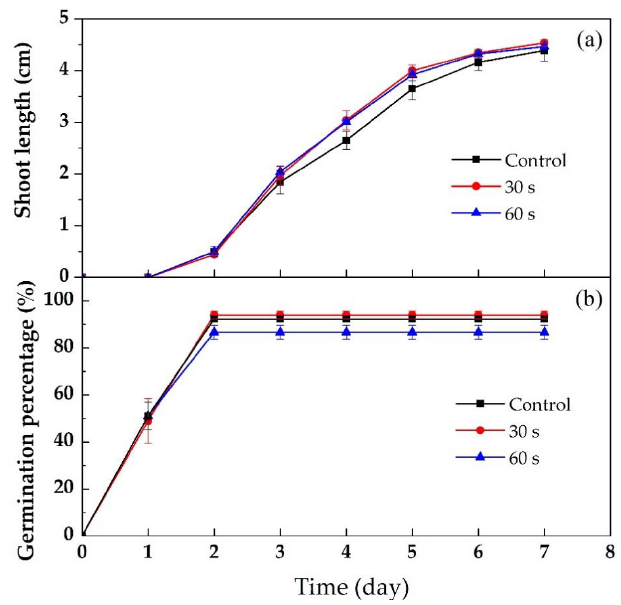
Figure 10. Effect of plasma seed treatment on broccoli cultivation ( a ) shoot length and ( b ) germination percentage on days 1–7.